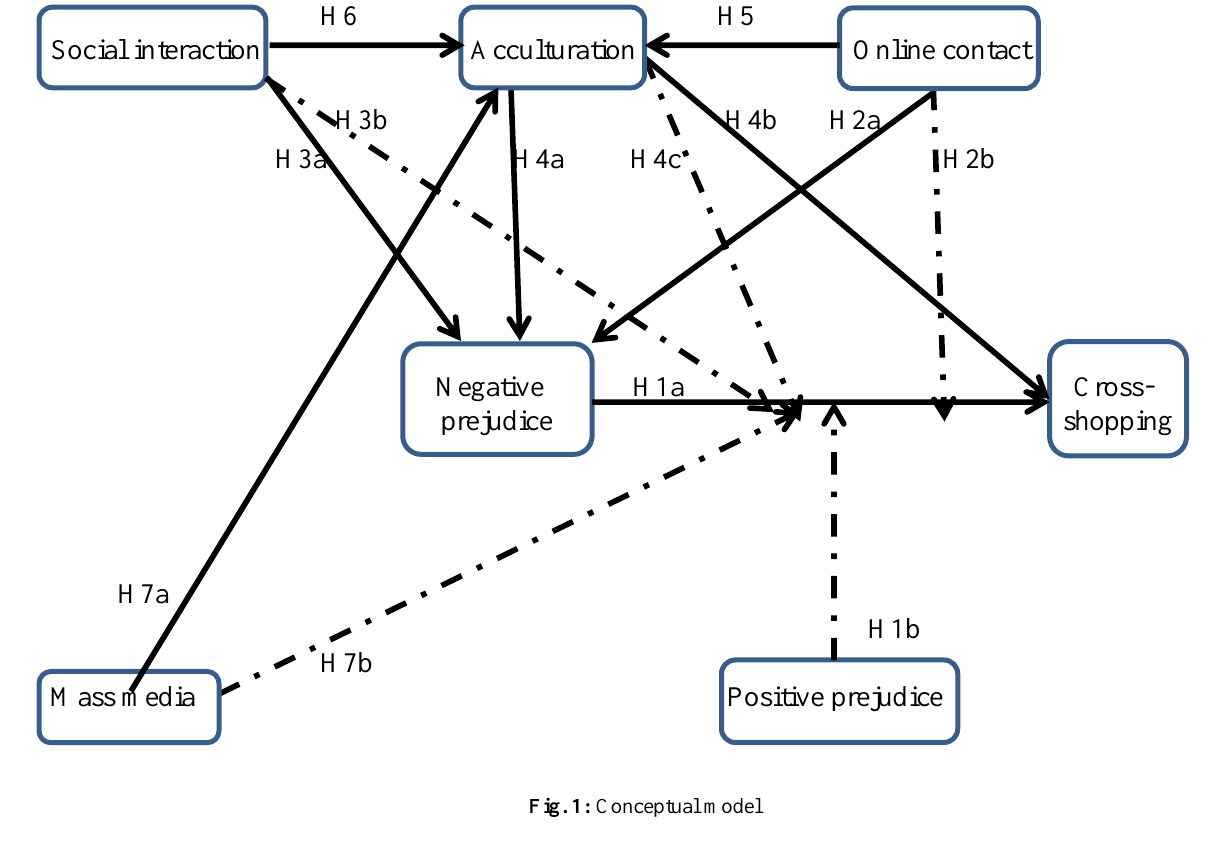
Fig. 1: Conceptual